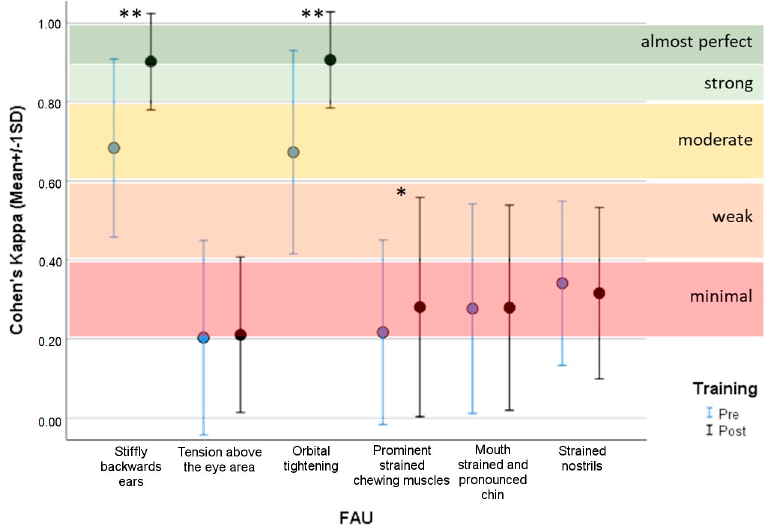
Figure 2. Mean ± SD of Cohen’s Kappa values between observers and a Horse Grimace Scale (HGS) expert pre- and post-training. Paired-sample t -test, ** p < 0.001 * p <